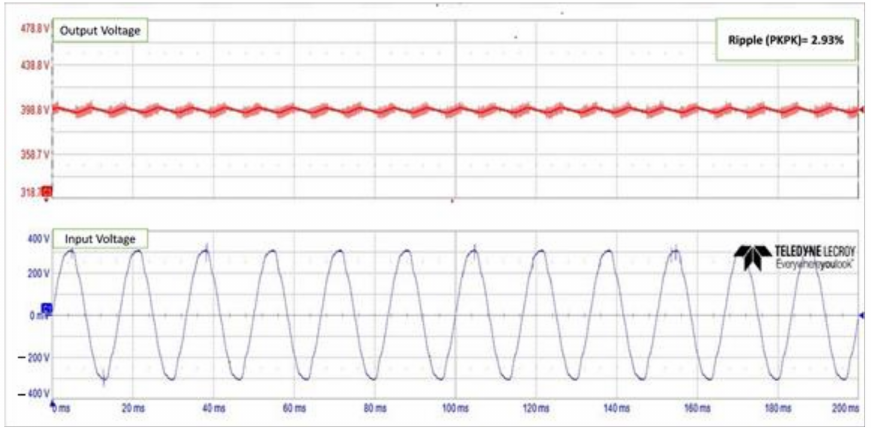
Figure 34. Input-output voltage waveforms of the designed PFC boost converter.